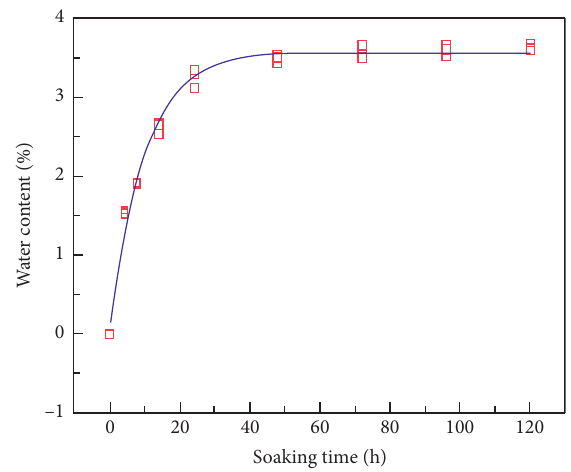
Figure 2: The relation between the water content and soaking time.